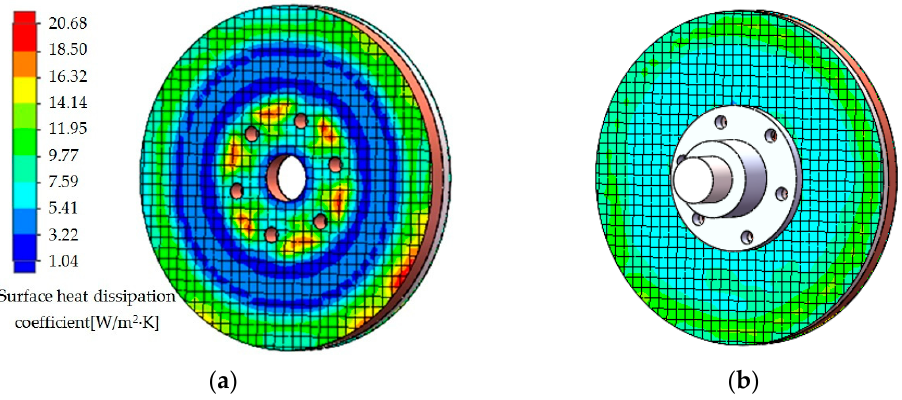
Figure 6. Simulation results of surface heat dissipation coefficient distribution. ( a ) Surface of the copper disk. ( b ) Surface of the back lining yoke iron disk.